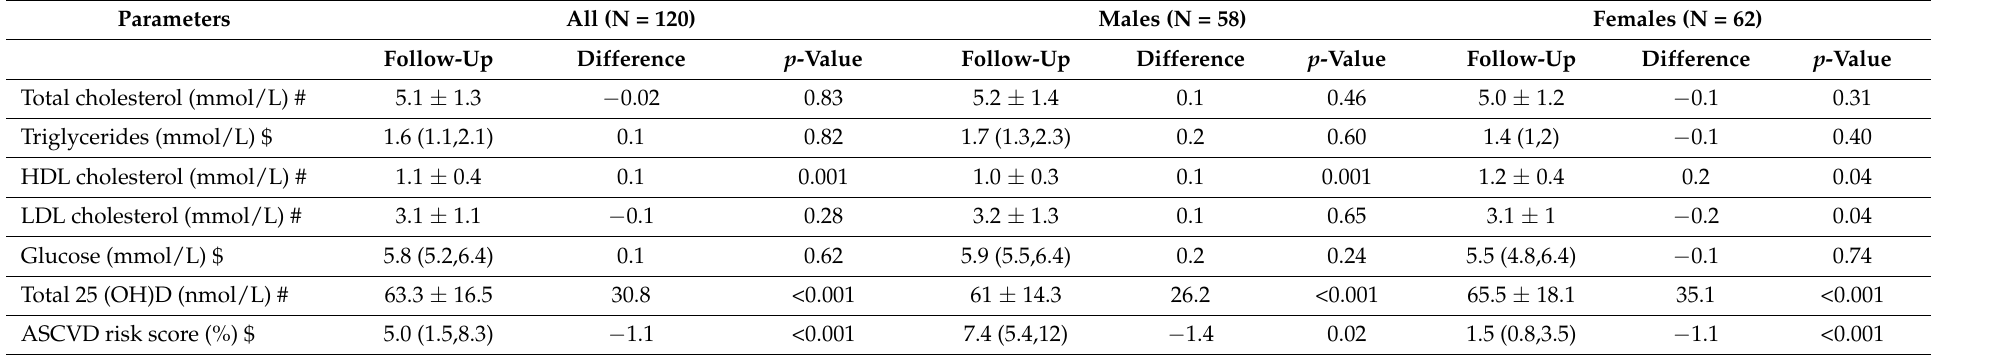
Table 2. Changes in biochemical characteristics of study participants post